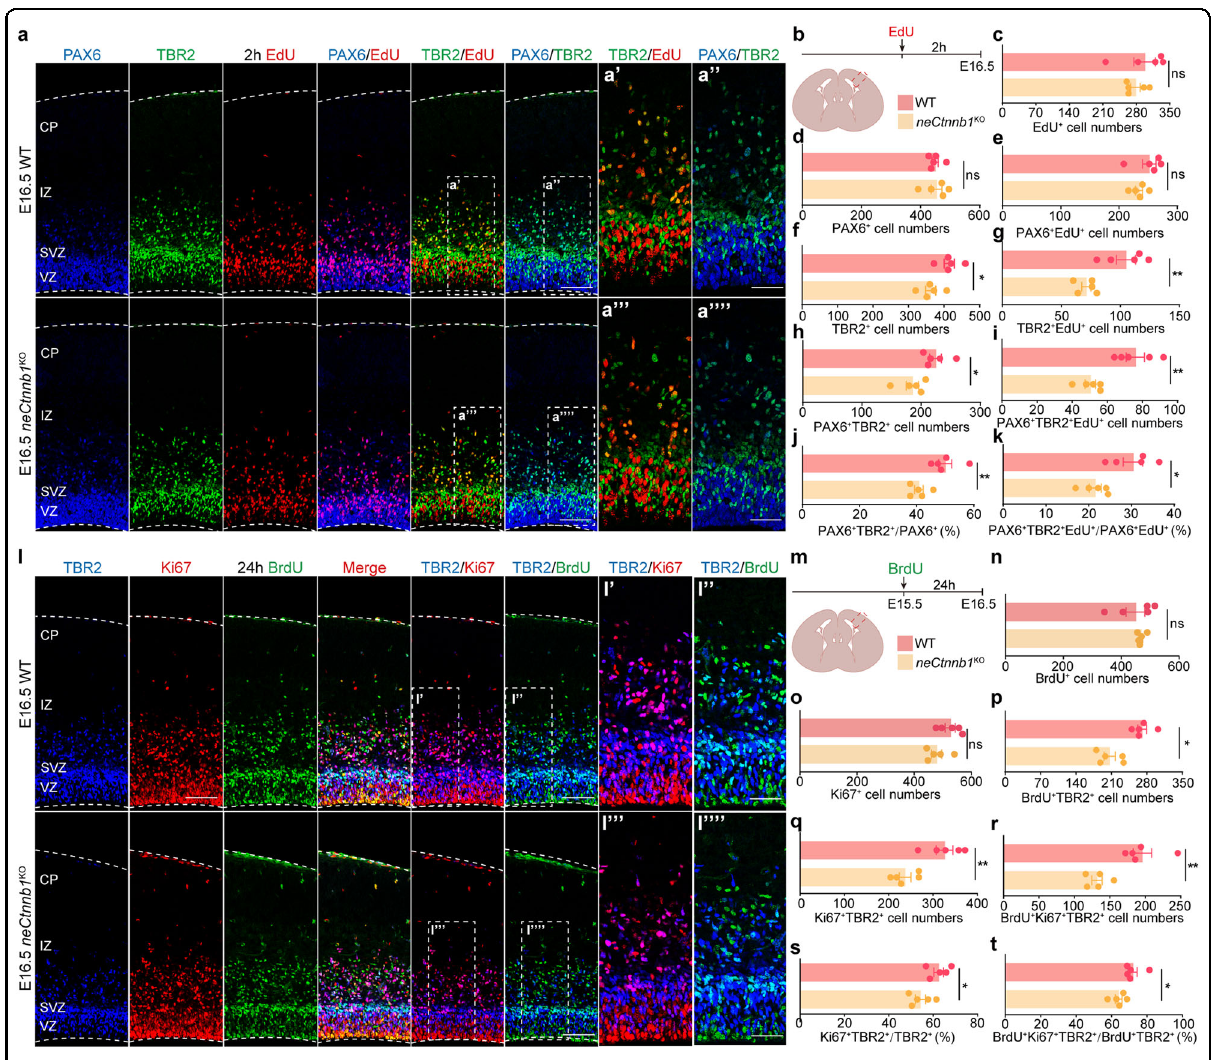
Fig. 3 neCtnnb1 knockout hampered the production and transit-ampli fi cation of IPs. a – k Immuno fl uorescence ( a ) and quanti fi cation ( c – k ) of EdU + (red), PAX6 + (blue) and TBR2 + (green) cells on boxed area of coronal sections ( b ) of E16.5 WT and neCtnnb1 KO Ncx. Pregnant mice were injected with EdU 2 h before sacri fi ce. Each point represents an individual brain. l – t Immuno fl uorescence ( l ) and quanti fi cation ( n – t ) of Ki67 + (red), TBR2 + (blue) and BrdU + (green) cells on boxed area of coronal sections ( m ) of E16.5 WT and neCtnnb1 KO Ncx. Pregnant mice were injected with BrdU at E15.5. m – t Quanti fi cation of data in l . Each point represents an individual brain. Quanti fi cation data are shown as means ± SEM. Statistical signi fi cance was determined using an unpaired two-tailed Student ’ s t -test ( c – k , n – t ). *P < 0.05, **P < 0.01, and ***P < 0.001. ns not signi fi cant. Scale bars, 100 μ m ( a and l ), 50 μ m (magni fi ed views in a , l